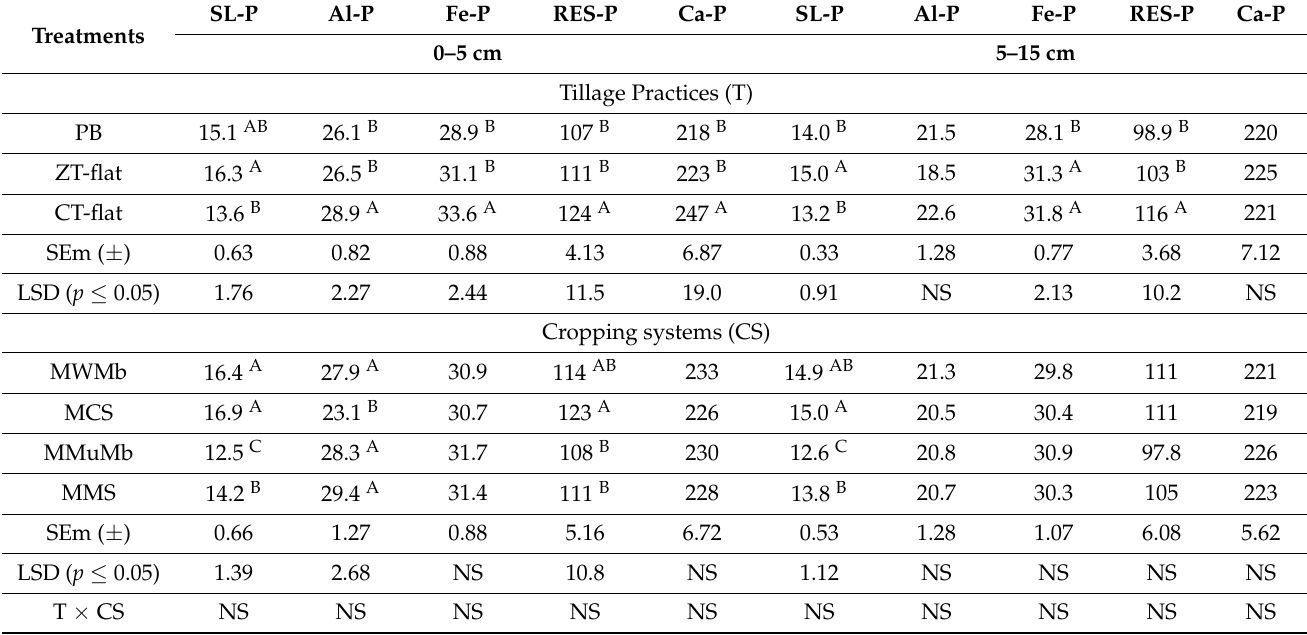
Table 3. Long-term impact of different tillage practices and maize-based crop rotation on inorganic P fractions (mg kg − 1 ) at different soil